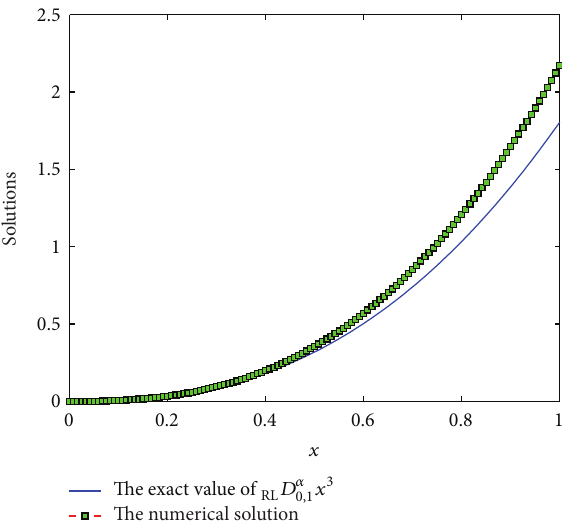
𝑥 3 and numerical solution of 𝑝 = 𝐷 𝛼 0,1 RL